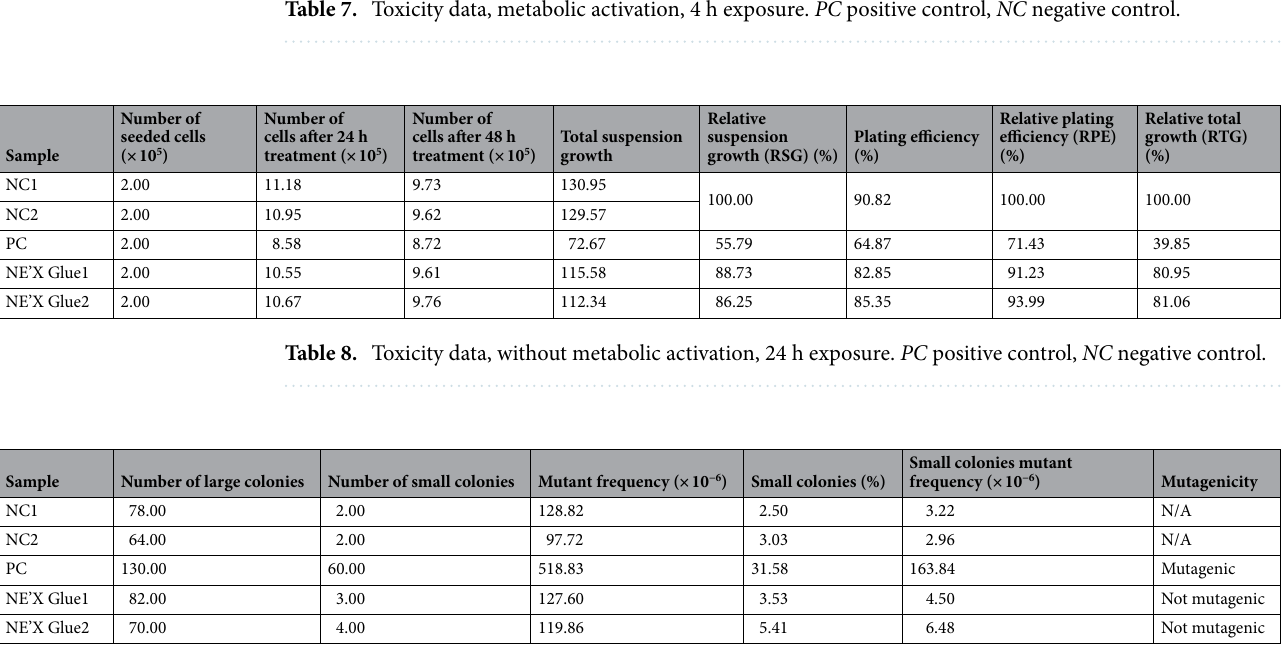
Table 9. Mutagenicity data, without metabolic activation, 4 h exposure. NC negative control, PC positive